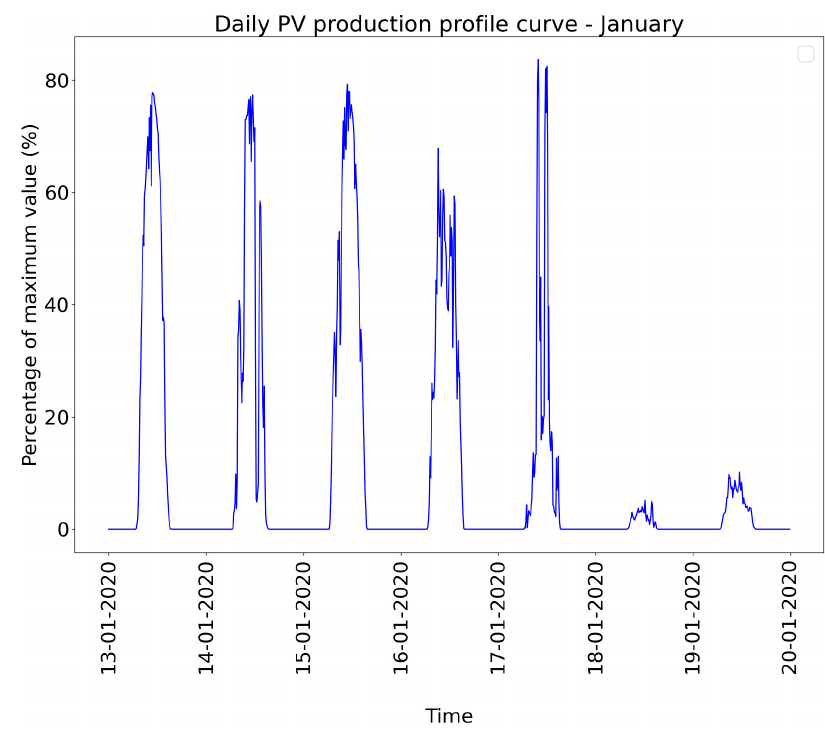
Figure A3. PV production profile curve—January.